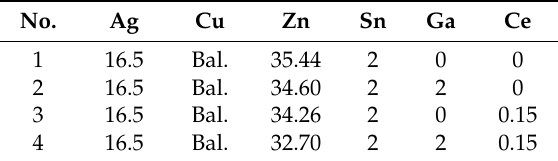
Table 1. Compositions of filler metals (wt.%).